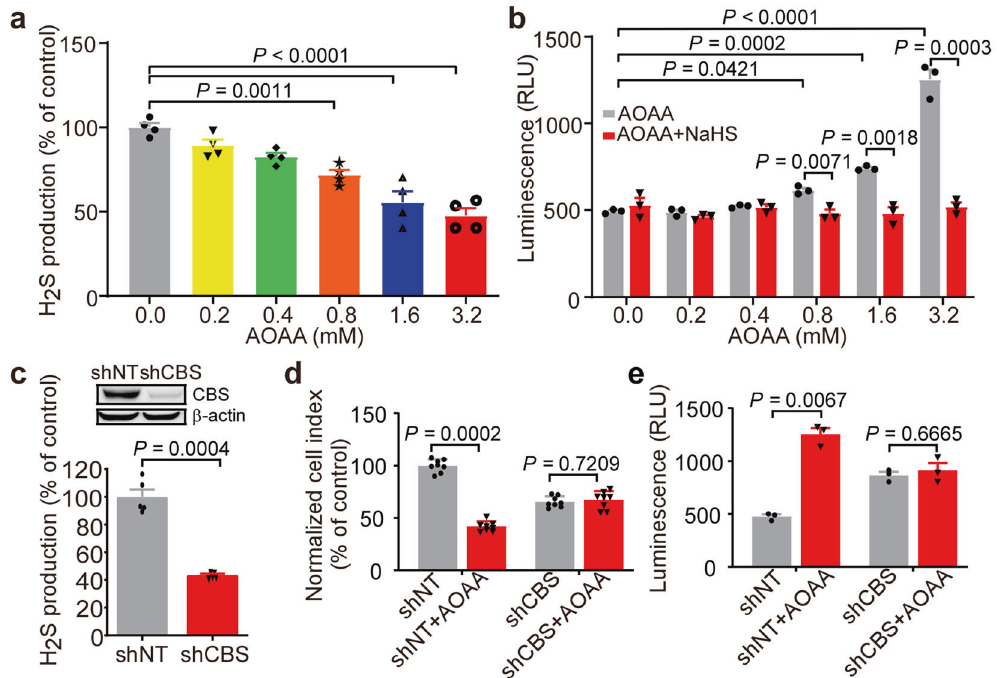
Fig. 5 Inhibition of CBS reduced endogenous H2S generation. a K562 cells were treated with AOAA (0.0, 0.2, 0.4, 0.8, 1.6, and 3.2 mM) for 48 h. Endogenous levels of H 2 S were detected by fl uorescence assays (ex = 365 nm, em = 450 nm). b K562 cells were treated with different concentrations of AOAA for 48 h with or without NaHS (30 μ M), caspase 3/7 activity was tested by using chemiluminescence method ( n = 3). c The K562 cells were transfected with CBS-shRNA lentiviral vector (shCBS) or the control group (shNT) and the level of H 2 S was analyzed ( n = 5). shNT and shCBS cells were treated with or not 1 mM AOAA for 48 h, cell viability ( n = 6) and caspase 3/7 activity ( n = 3) were detected by MTT ( d ) or chemiluminescence method ( e ), respectively. The results are expressed as mean ± SEM. Two-tailed Student ’ s t test was used to analyze the difference between 2 groups, and multiple comparisons were analyzed by ANOVA followed by Tukey ’ s multiple comparisons